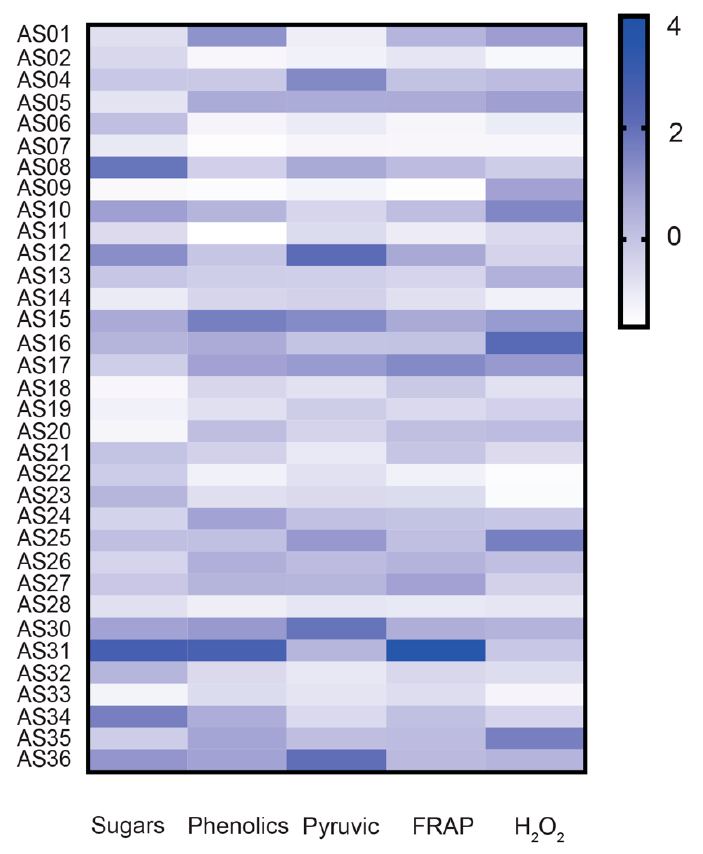
Figure 1. Heat map showing the variation of total sugars, phenolics, and pyruvate, and the antioxidant properties by FRAP and H 2 O 2 scavenging assays in 34 garlic genotypes. Standardized values (z-scores) of mean values are depicted with color scale (from light to intense blue). Raw data are provided in Table 4.